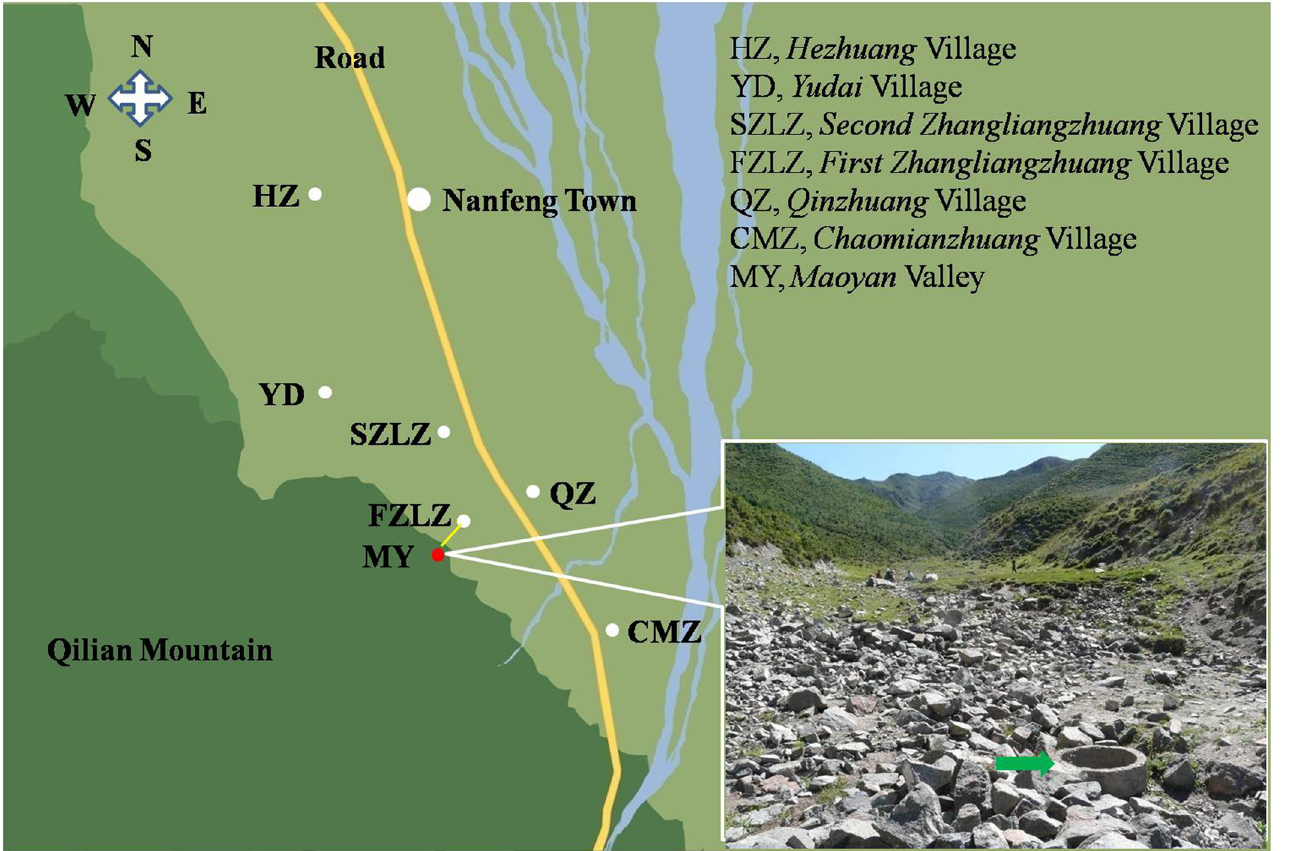
Fig 1. The location of FZLZ and the other five villages of Nanfeng Town of South Minle